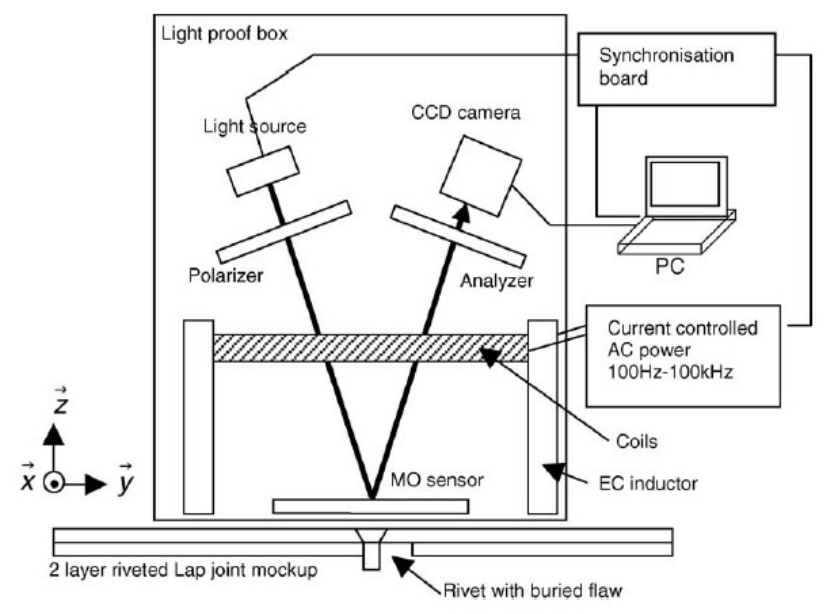
Figure 24. Schematic of the LMOI.